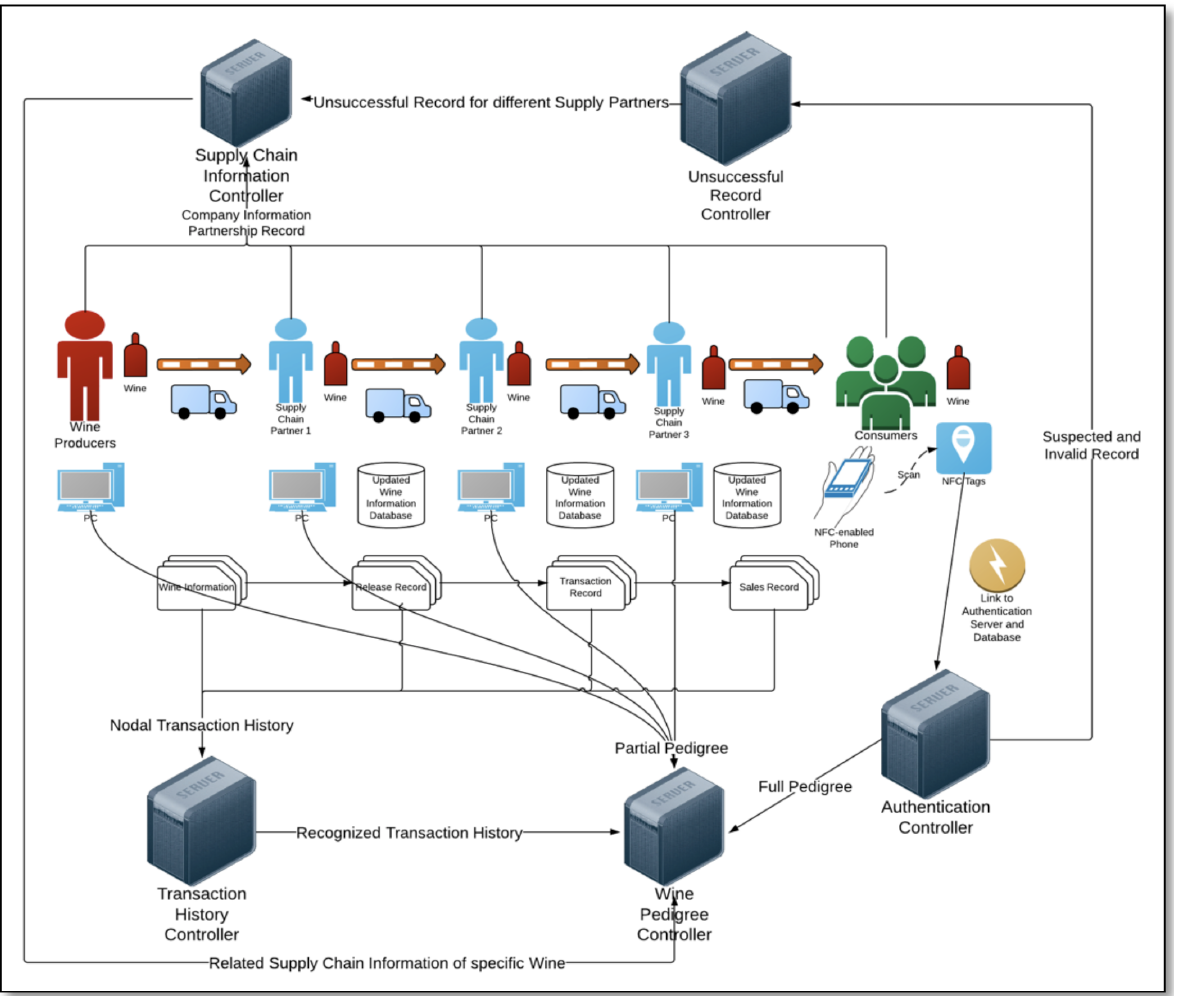
Figure A1. The System Architecture of Legacy NAS (Source: Neo